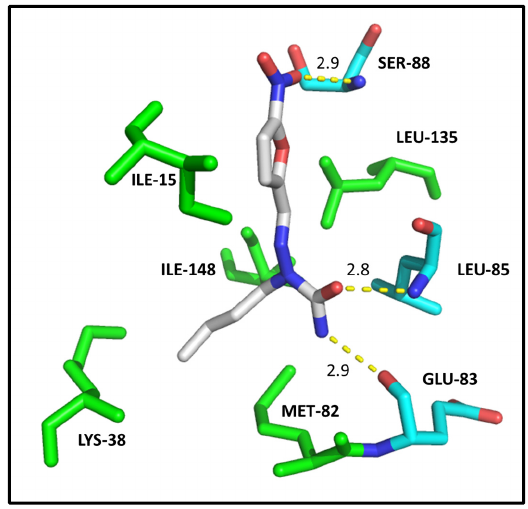
Figure 3. Detailed view of the docking pose for compound 4a regarding the CK1 δ / ε target. Residues involved in hydrophobic interactions (green) and hydrogen bonds (colored per element with carbon atoms in cyan) are highlighted.